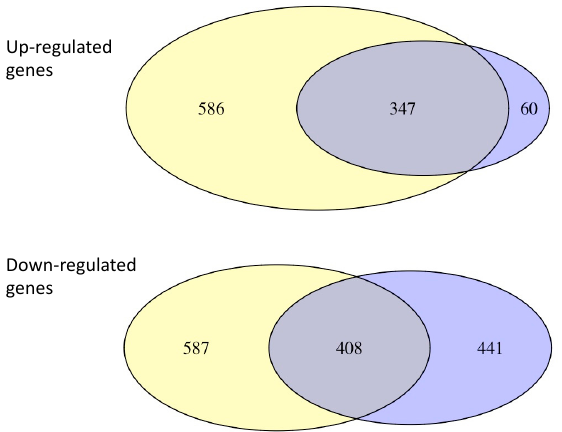
Figure 5. Overlap of up- and downregulated genes in young and mature spherules. Legend: Comparison of up- and downregulated genes in young spherules and mature spherules. Blue represents young spherules, yellow represents mature spherules.